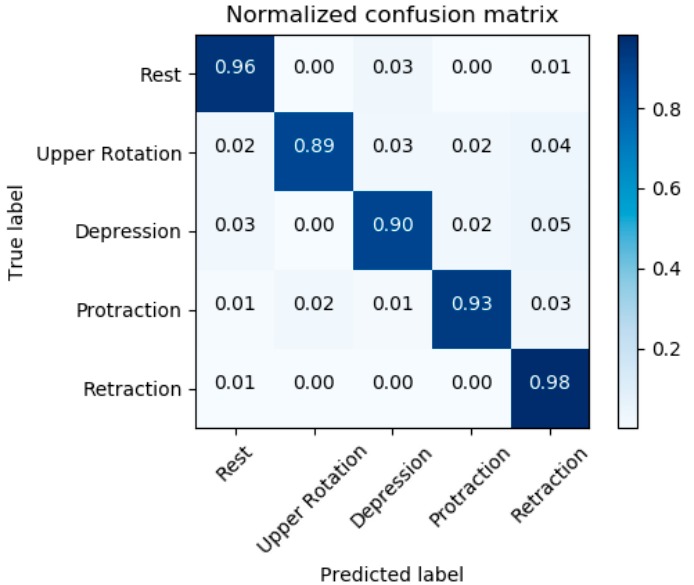
Figure 12. Confusion matrix of five postures where the CNN was trained and verified using all the data collected from five subjects.